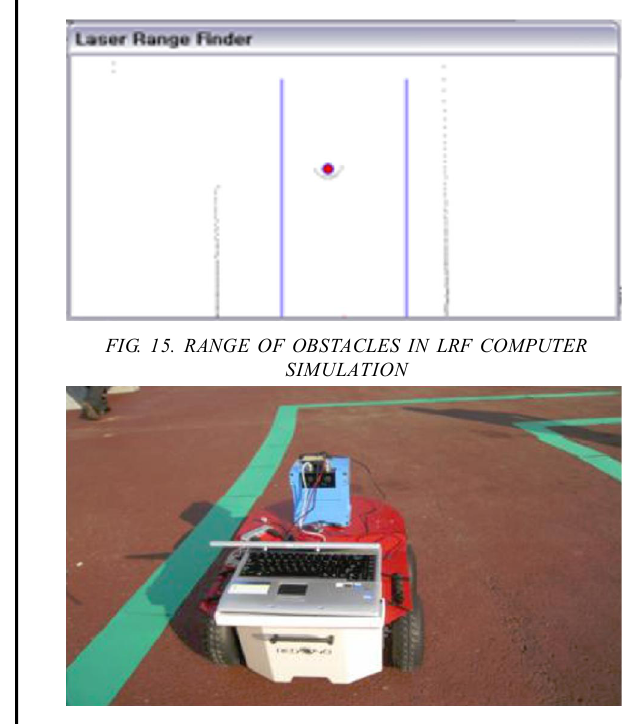
FIG. 16. MOBILE ROBOT ON NAVIGATION